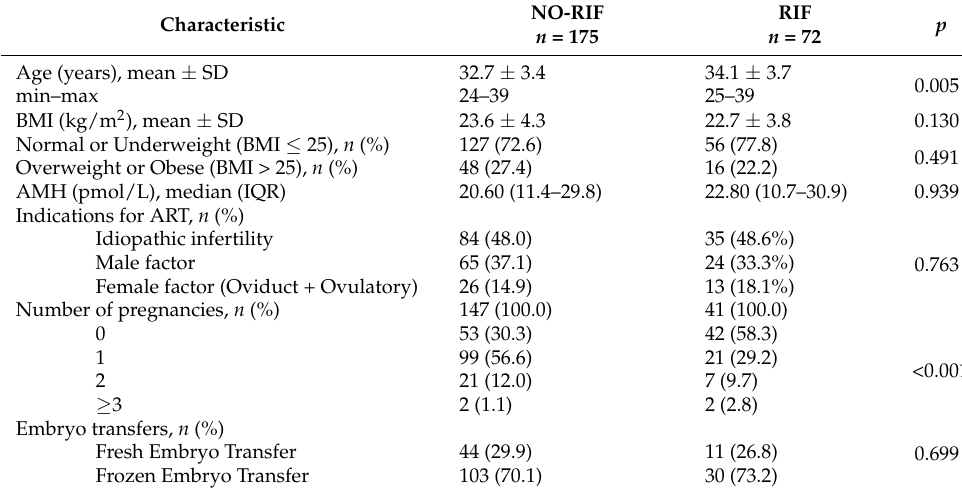
Table 4. Clinical characteristics of infertile women divided into RIF and NO-RIF